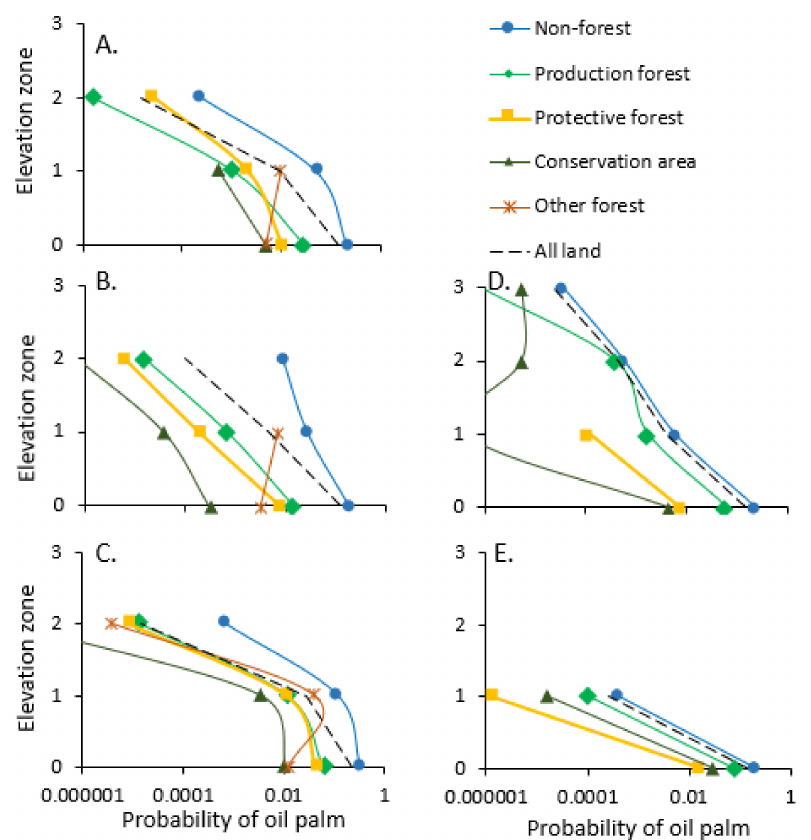
Figure A1. Probability of land having oil palm as land cover at four elevation zones (0 = 0–100; 1 = 100–300; 2 = 300–1000; 3 = > 1000 m a.s.l.) in two provinces (( A – C ), West Kalimantan; ( D , E ) Jambi), for specified land use designations outside and inside the forest-zone, according to three data sources (( A ) [75]; ( B , D ) [33]; ( C , E ) [28]); (NB log scale on the